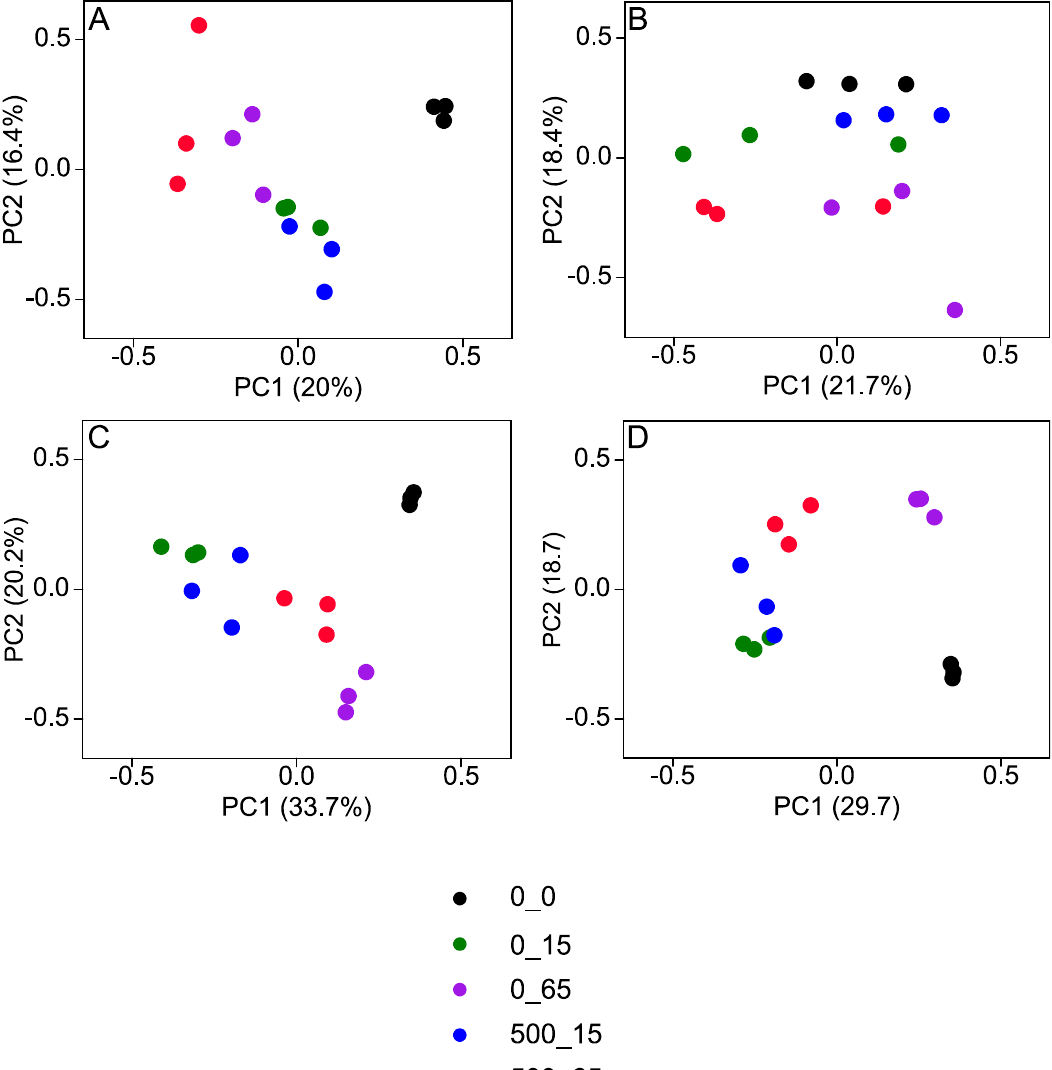
Figure 4. Principal coordinate analysis based on Bray-Curtis dissimilarity metric showing the effect of TrOCs on the bacterial community composition on operational taxonomic unit (OTU)-level from 16S rRNA gene ( A , C ) and 16S rRNA ( B , D ) data for surface ( A , B ) and subsurface ( C , D ) sediment samples, respectively. Sample code: 0, 500 indicate supplemental TrOC concentrations in µg L − 1 . 0, 15, 65 represent sampling days.